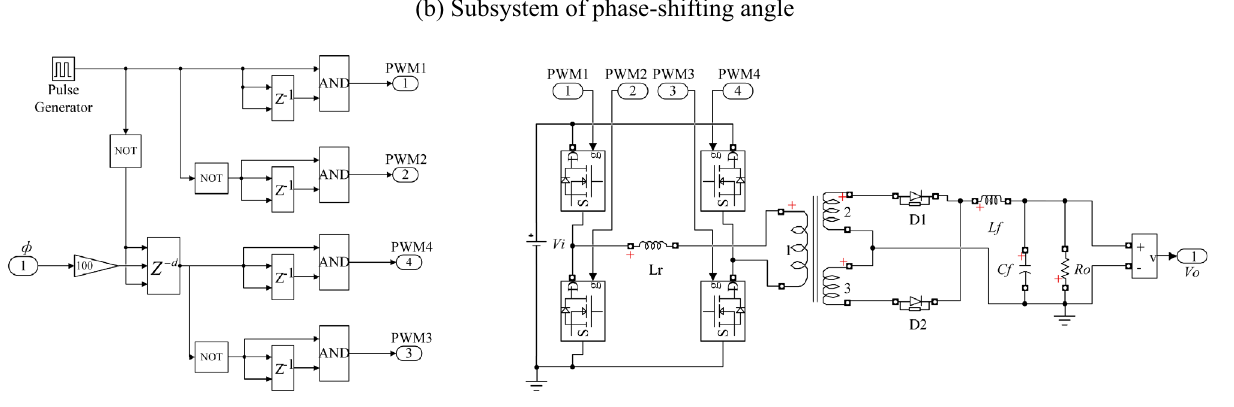
Figure 15. Circuit model of the closed-loop